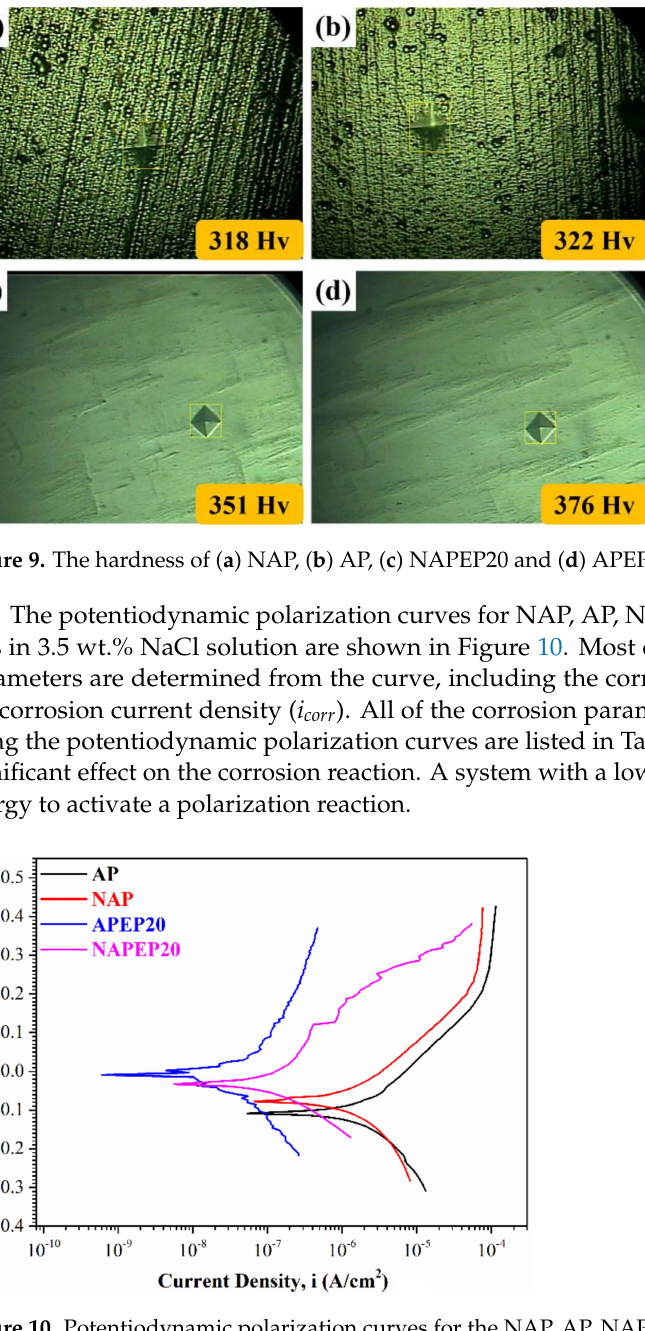
Figure 10. Potentiodynamic polarization curves for the NAP, AP, NAPEP20 and APEP20 samples in 3.5 wt.% NaCl